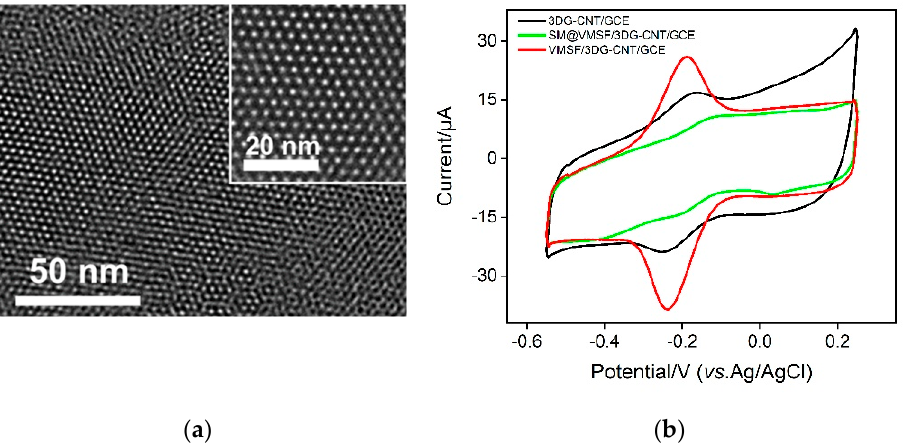
Figure 2. ( a ) Top-view TEM image of the VMSF. The inset is the corresponding magnified image. ( b ) CV curves obtained for different electrodes in a 0.05 M KHP solution containing 0.5 mM [Ru(NH 3 ) 6 ] 3+ .